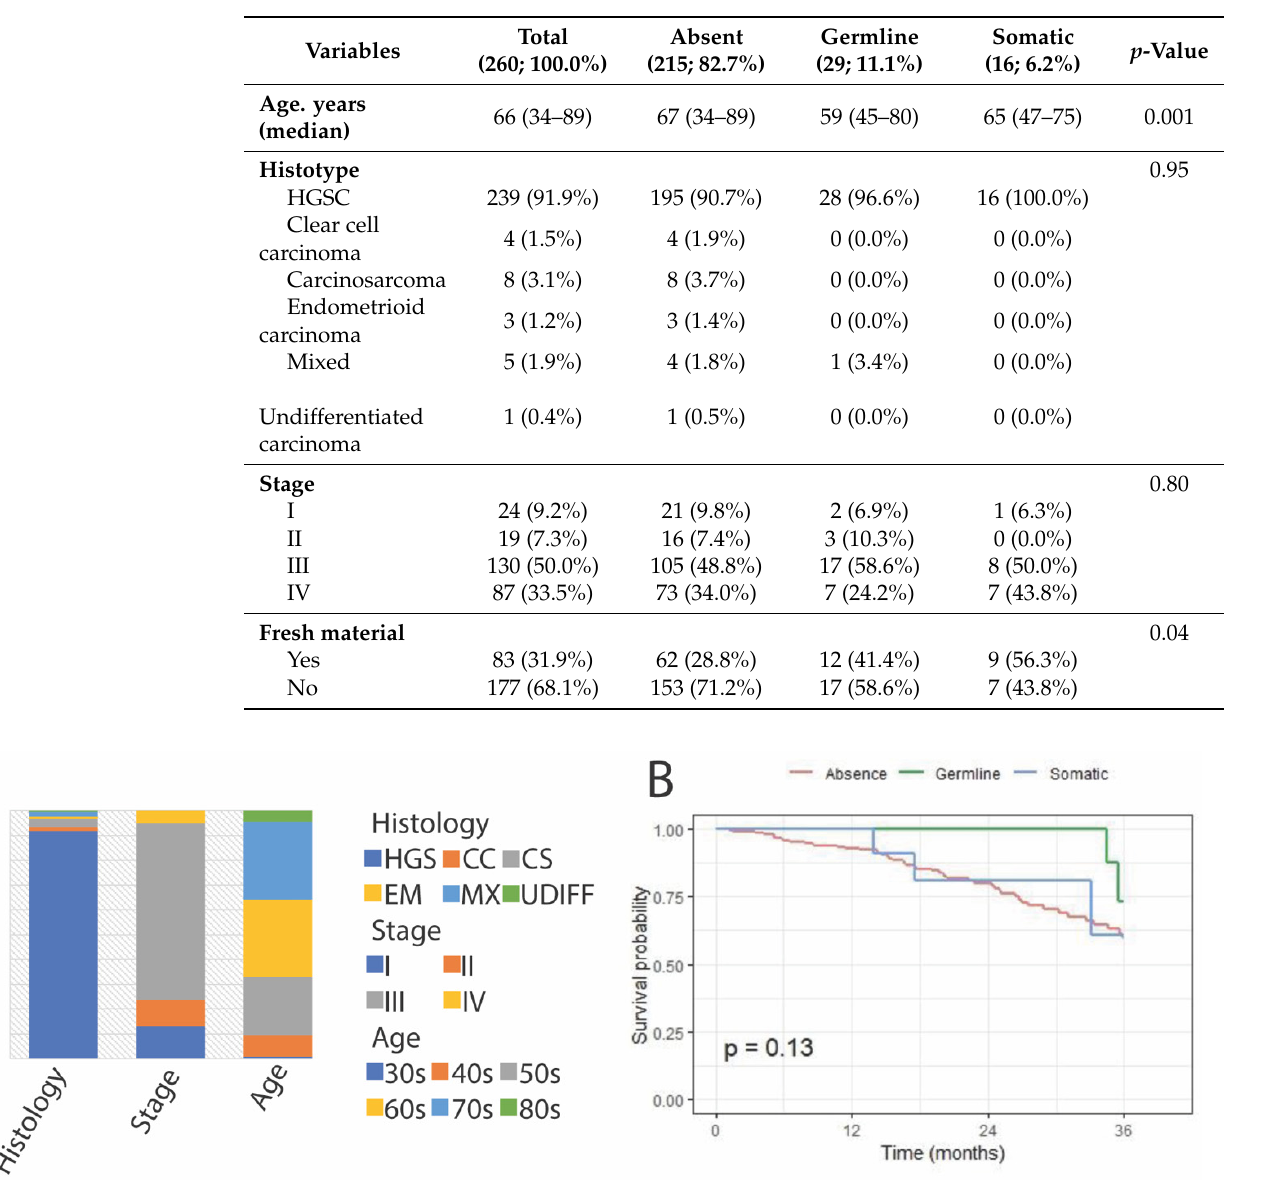
Figure 1. ( A ) Characteristics of the Karolinska cohort by histology, stage, and age. ( B ) Overall survival of the cohort by the BRCA1/2 pathogenic variant status (absent, germline or somatic).